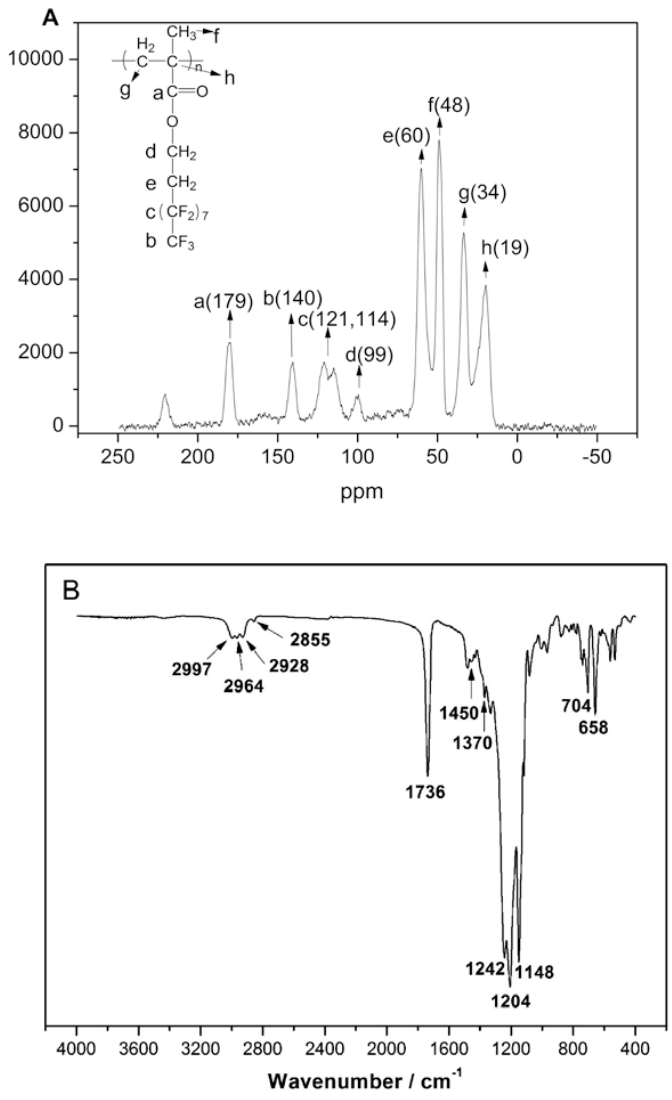
Figure 2. 13 C-NMR ( A ) and Fourier transform infrared (FT-IR) spectrum ( B ) of PFMA nanoparticles.